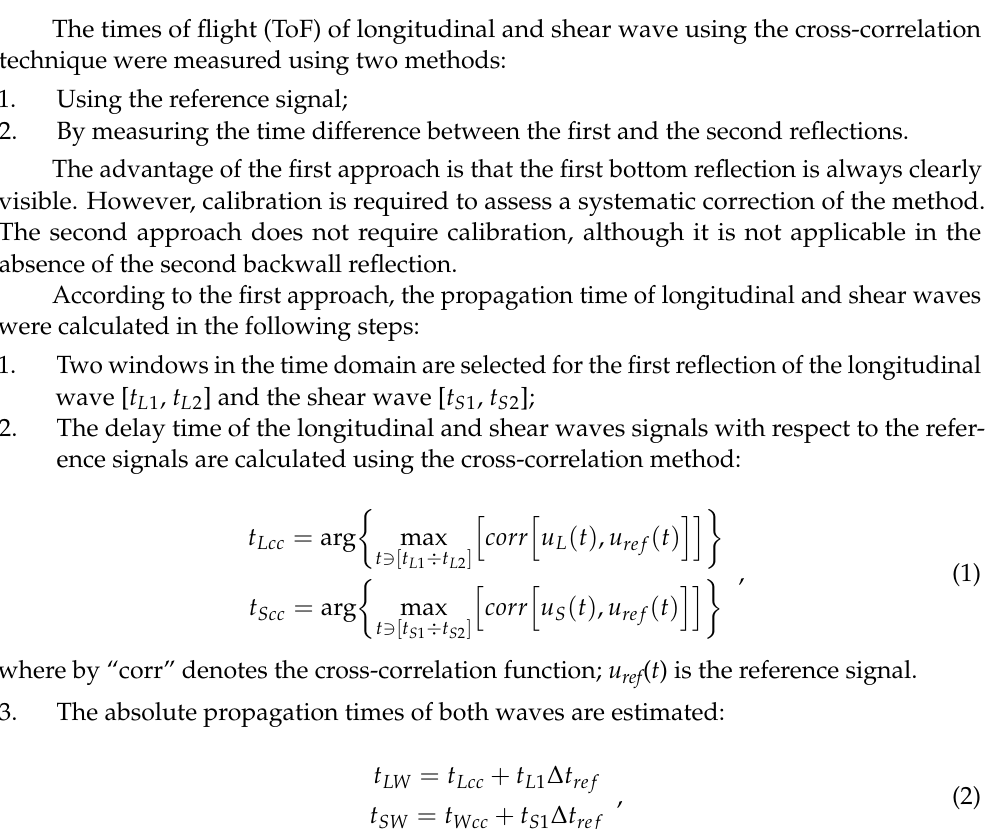
cate the time windows for the first backwall reflection, the circle markers show time gates for the second backwall reflection.